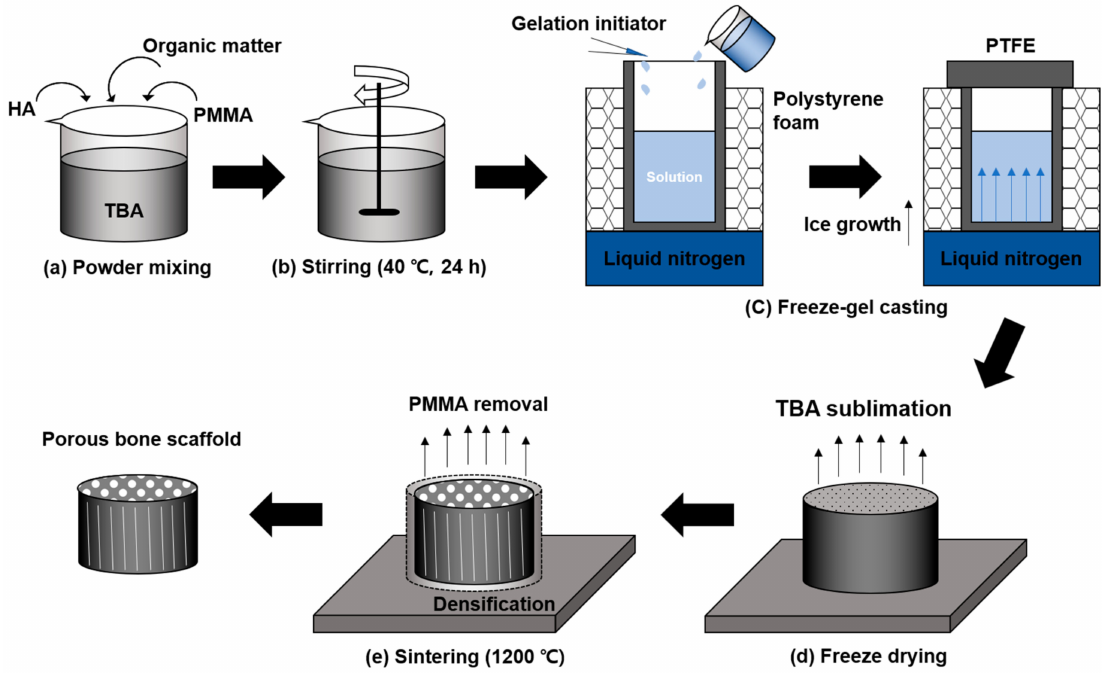
Figure 1. Freeze-gel casting steps with di ff erent PMMA addition amounts to obtain novel porous structures of the bone sca ff